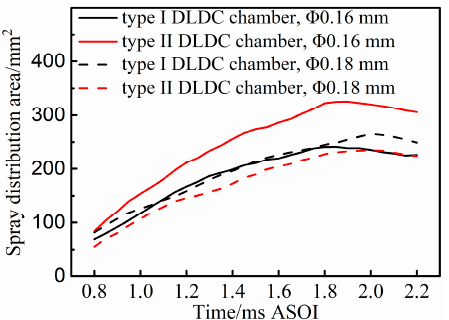
Figure 19. The comparison of fuel spray distribution areas between the two DLDC chambers with full load, different nozzles, 150 injection pressure and 15 °CA BTDC injection timing of Mode C.